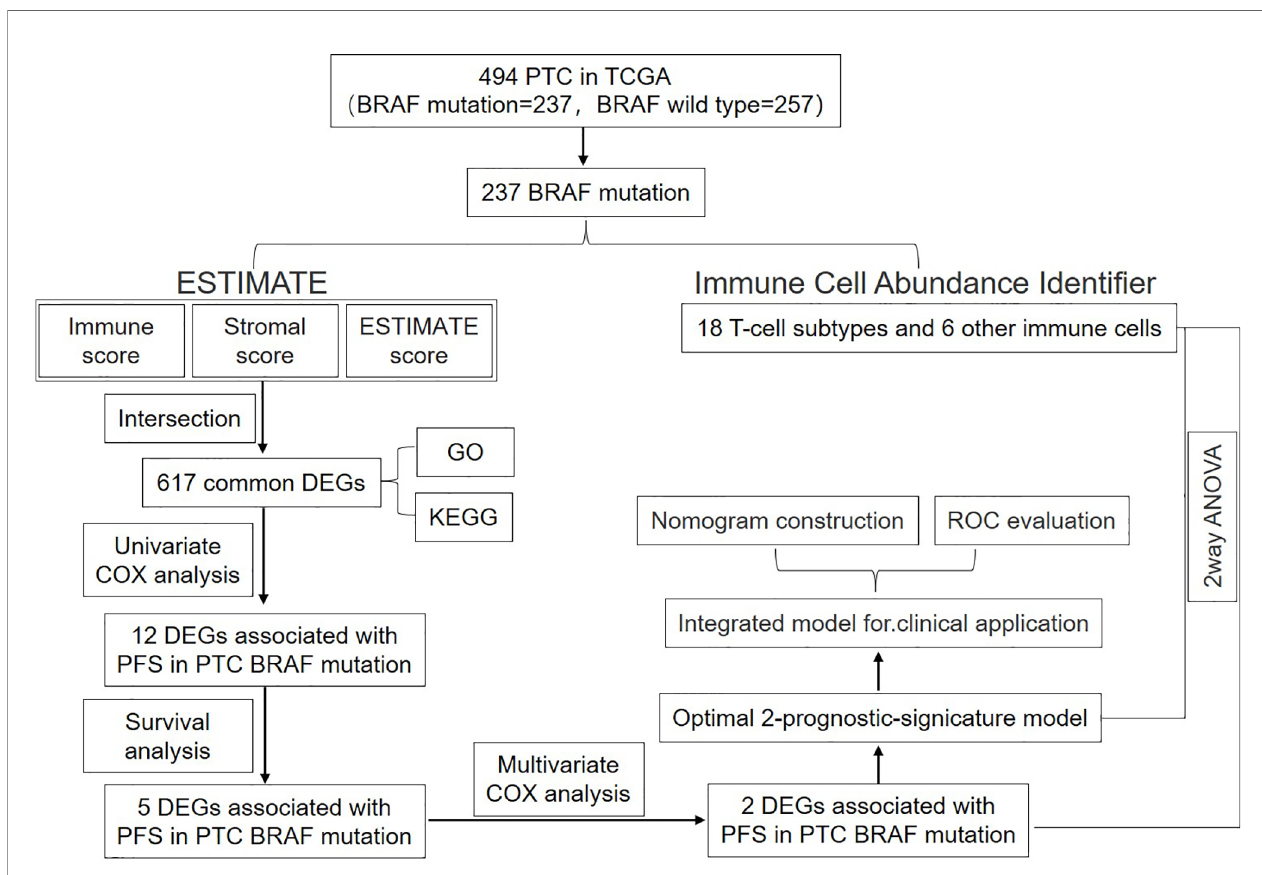
FIGURE 1 | Analysis work fl ow of this